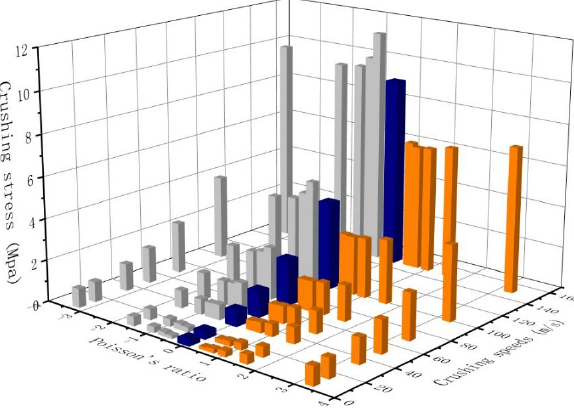
Figure 2: Impact strength of honeycombs in terms of Poisson’s ratio and crushing speeds.